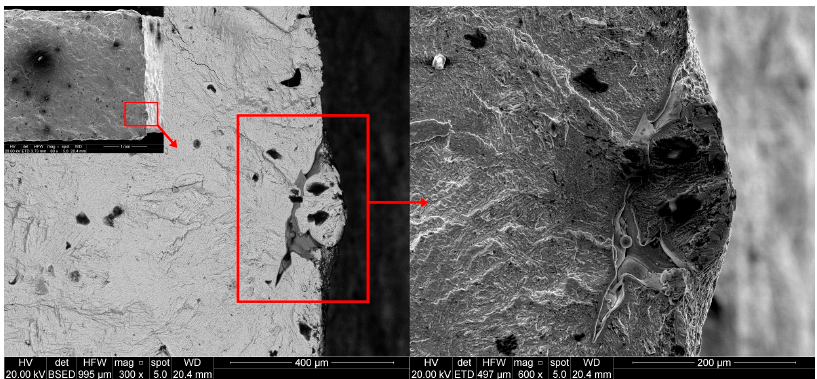
Figure 7. ESEM fractographs of the double circular notched specimen ( Δσ = 360 MPa, Cycles Number = 64427).